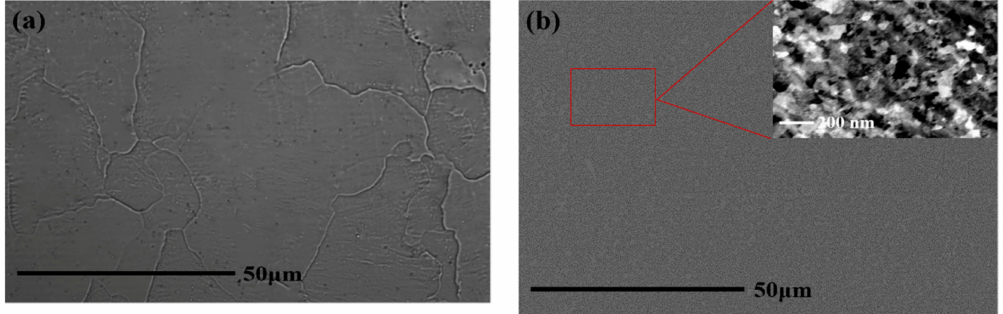
Figure 3. Pre-irradiation scanning electron microscopy (SEM) images for ( a ) pure W bulk and ( b ) nanocrystalline W film